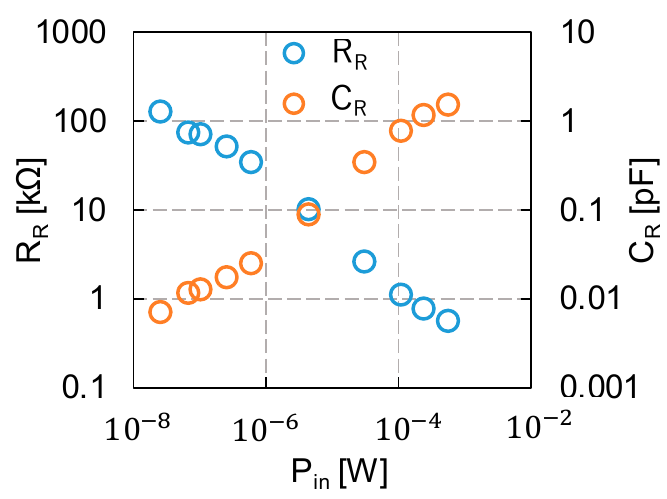
Figure 15. Input power dependence of 𝑅 (cid:3019) and 𝐶 (cid:3019) of L32.